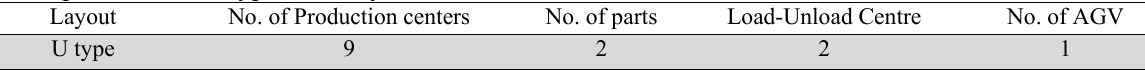
Description of the U-type FMS layout Layout No. of Production centers No. of parts Load-Unload Centre No. of AGV U type 9 2 2